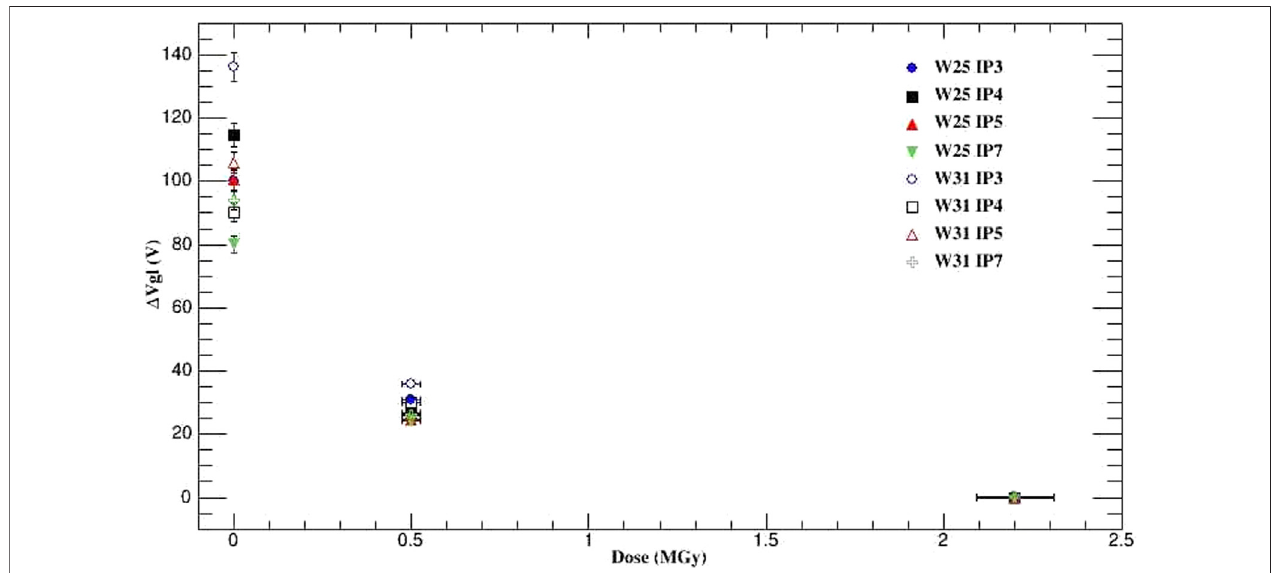
FIGURE 8 | The difference between V gl for the electrodes connected directly to ground, and V gl for electrodes fl oating, as a function of dose and interelectrode separation. This indicates the voltage needed for punch-through.